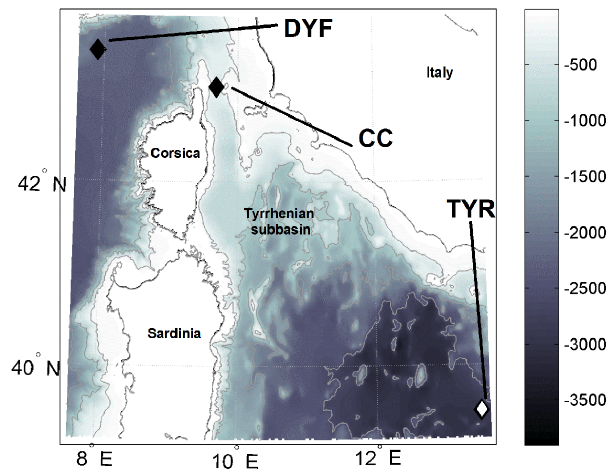
Fig. 9. Location of the monitoring sites in the Tyrrhenian– Ligurian subbasins (TYR=Tyrrhenian, CC=Corsica Channel,